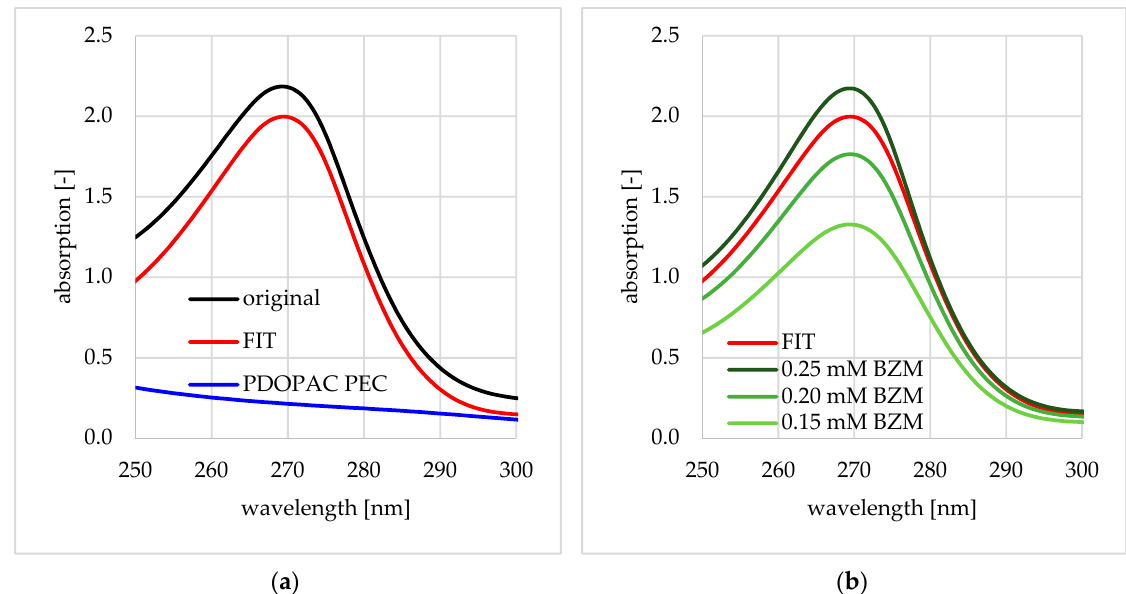
Figure 2. Well-defined subtraction of UV/VIS spectra related to Equation (4). In ( a ) the UV/VIS spectra of BZM containing the supernatant before and after subtraction as well as the pure PDOPAC/PEC spectrum (subtrahend) and in ( b ) the corrected spectrum of the supernatant in comparison to pure BZM spectra of selected concentrations is